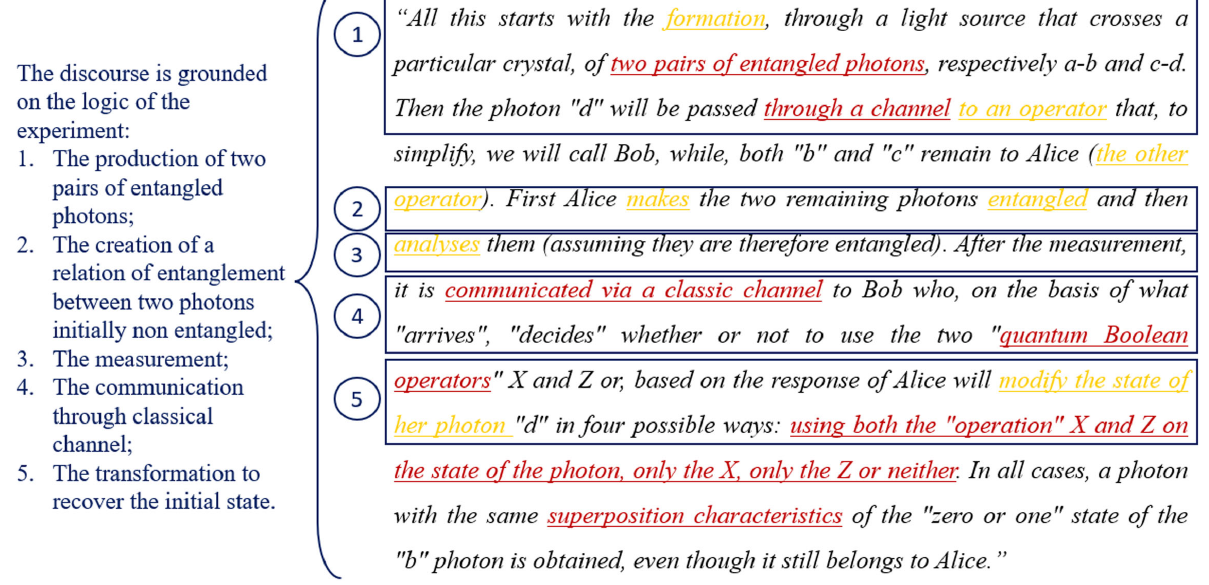
FIG. 24. Analysis of answer #2 — on the left, the structure of the discourse; in yellow, the “ main actors ” ; in red, the key-words characterizing the